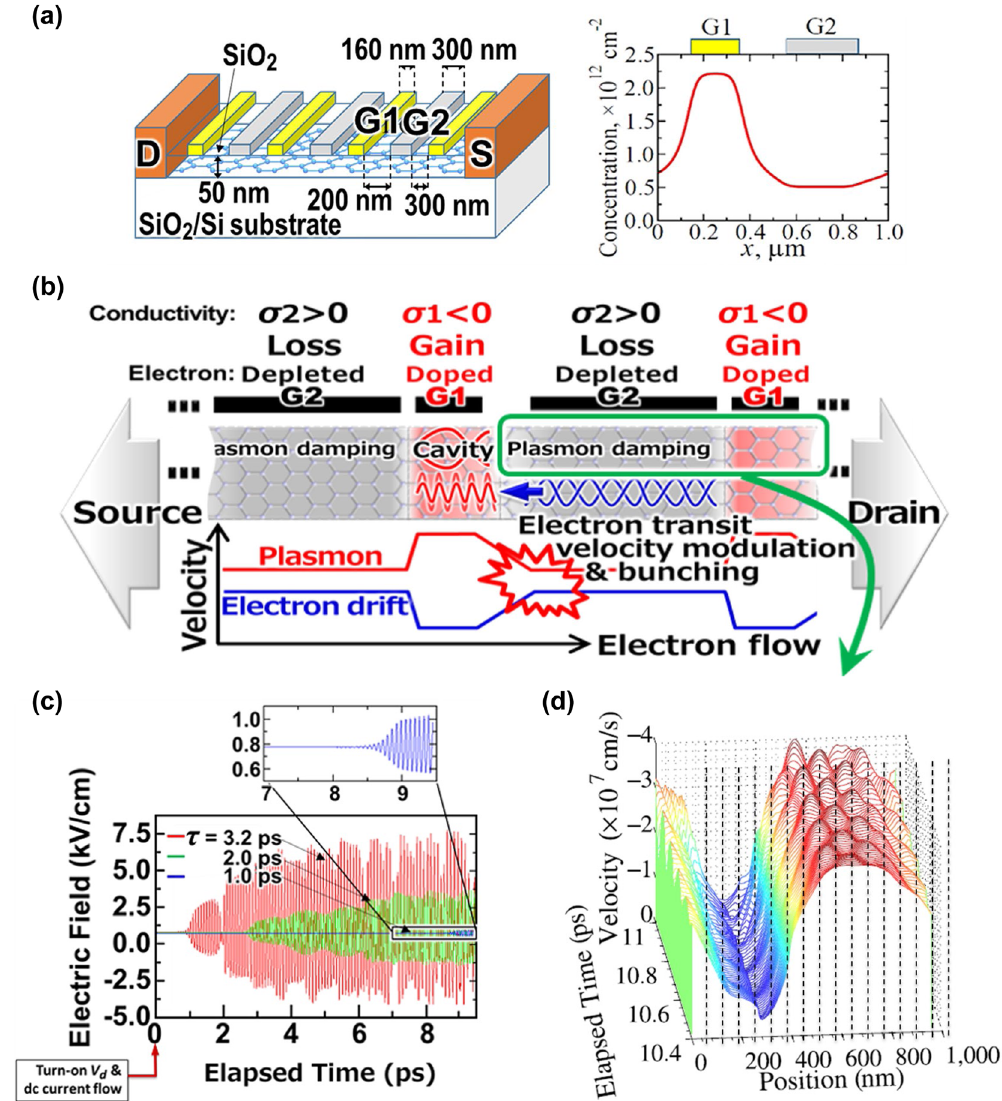
Figure 13: An idea and impact for implementation of the PT-symmetric system in a DGG-GDPP metasurface. (a) An asymmetric DGG-GFETstructure (left) and periodic doping (right). (b) A possible scenario to promote the TTM-type GDP instability in the DGG-GFETmetasurface. (c) Numerically simulatedtemporal evolutions of the longitudinal electricfield intensity inthe GDP cavity for different carrier momentum relaxation times when the drain bias voltage V d is turned on at time zero. (d) Numerically simulated time-varying spatial distribution of the longitudinal electric fi eld intensity in the unit PT-symmetric cell in the GDP